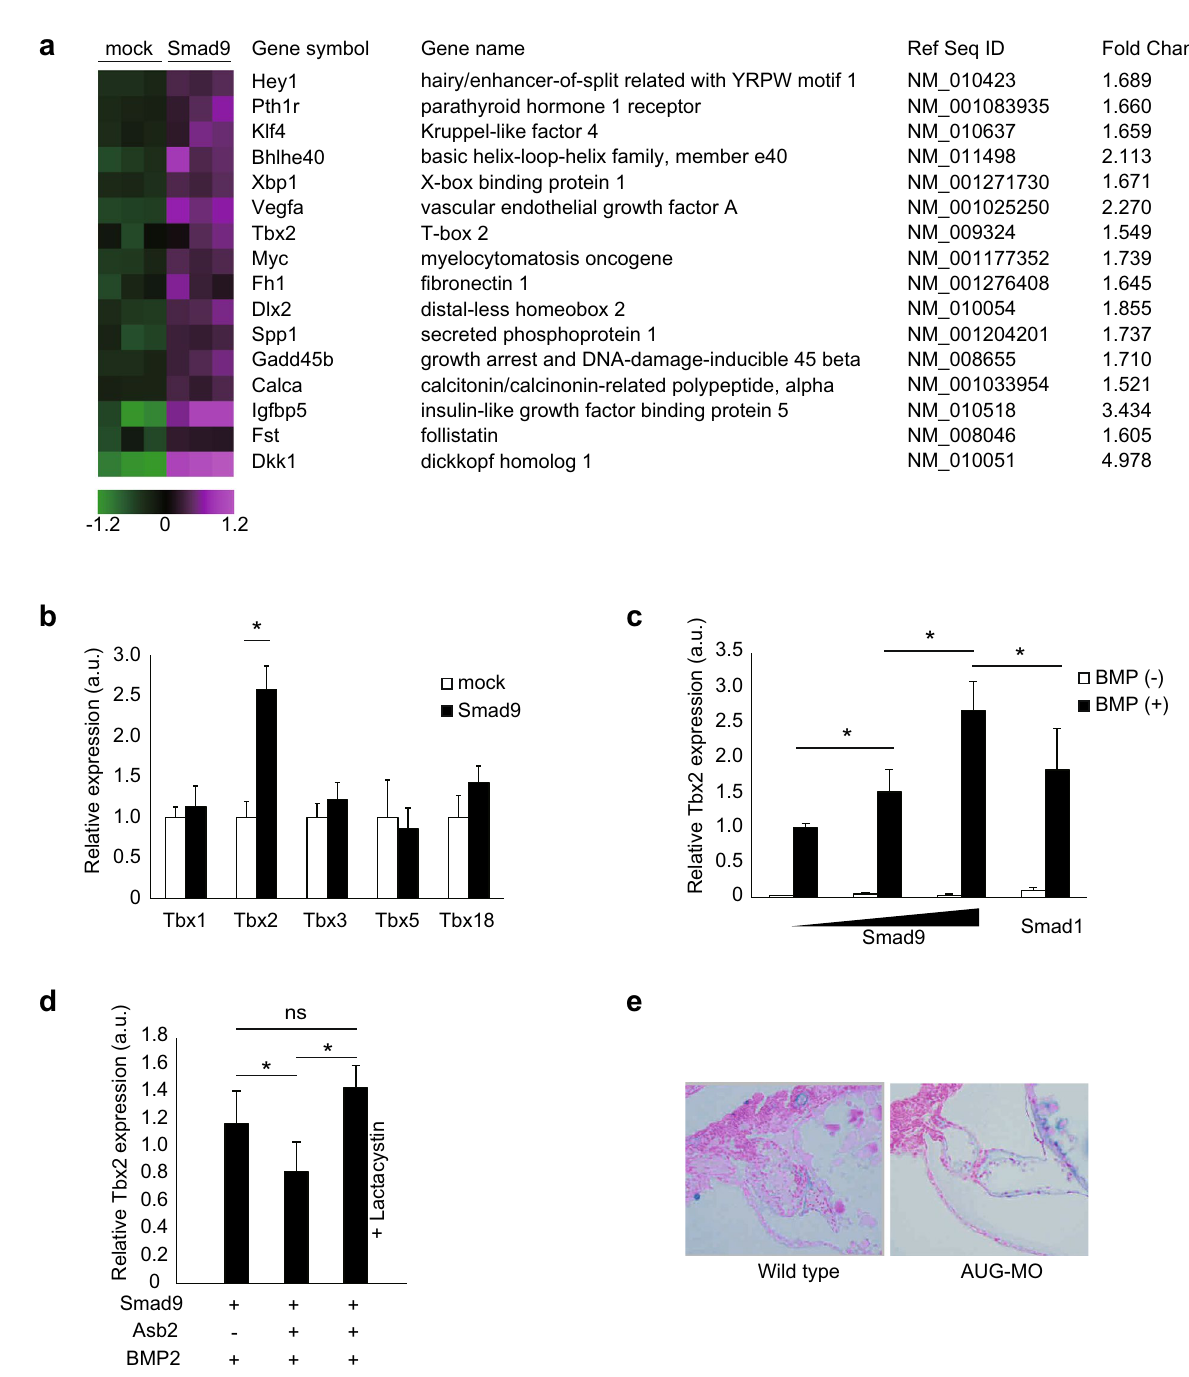
Figure 7. Tbx2 expression is regulated by SMAD9. ( a ) Search for SMAD9 target genes through comprehensive gene expression analysis. P19CL6 cells were transfected with either the mock vector or the vector coding Flag-SMAD9 and treated with 100 µM BMP2 for 24 h. RNA was collected and subjected to microarray analysis. Sixteen BMP-responsive genes were significantly upregulated by forced expression of SMAD9. ( b ) P19CL6 cells were transfected with either the mock vector or the vector encoding Flag-SMAD9 and treated with 100 µM BMP2 for 24 h. The expression levels of indicated genes were determined using quantitative real-time PCR. Among Tbx family, only Tbx2 was significantly induced by forced expression of SMAD9 under BMP2 stimulation. ( c ) From the left, 0, 0.1, and 1.0 µg of vector encoding Flag-SMAD9 and 1.0 µg of vector coding Flag-SMAD1 were transfected into P19CL6 cells. The expression level of Tbx2 was positively correlated with the amount of SMAD9. Greater induction of Tbx2 was observed upon transfection of SMAD9 compared to SMAD1. ( d ) Tbx2 expression was induced by treatment with BMP2. The expression level of Smad9 was blunted by co-expression of ASB2. The blunting effect of ASB2 was cancelled by treatment with 10 µM lactacystin for 16 h. ( e ) The histological section of zebrafish was subjected to alcian blue staining to visualize excess extracellular matrix induced by misexpression of Tbx2. The data are shown as the mean ± s.d. Statistical analysis was performed using one-way ANOVA with Tukey’s multiple comparison tests. * p < 0.05; ns, not significant; a.u., arbitrary